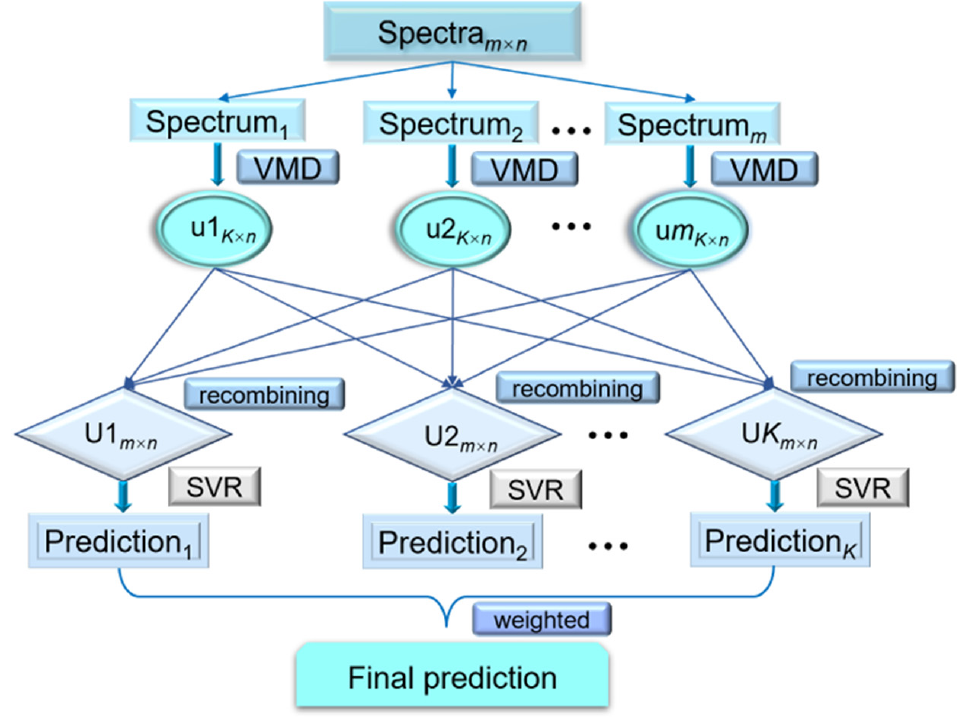
Figure 2. The schematic diagram of